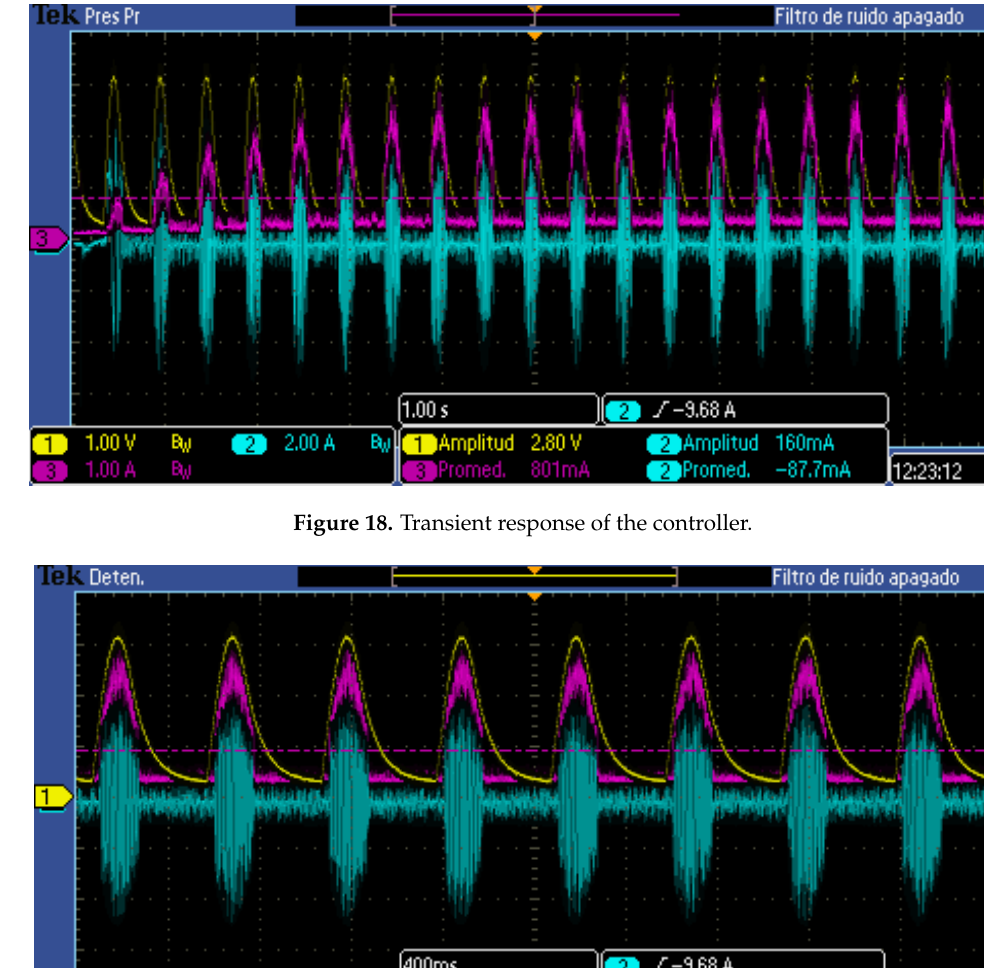
Figure 20. Motor current under control. Reference signal frequency: 1 Hz. In Figure 21, the reference signal frequency increases, consistent with a cyclist pedaling faster. In this case, the period of the motor current and the pedaling frequency became comparable, degrading the ability to track the pedaling torque with precision. This could be solved by increasing the gear ratio between the motor and the pedaling sprockets.